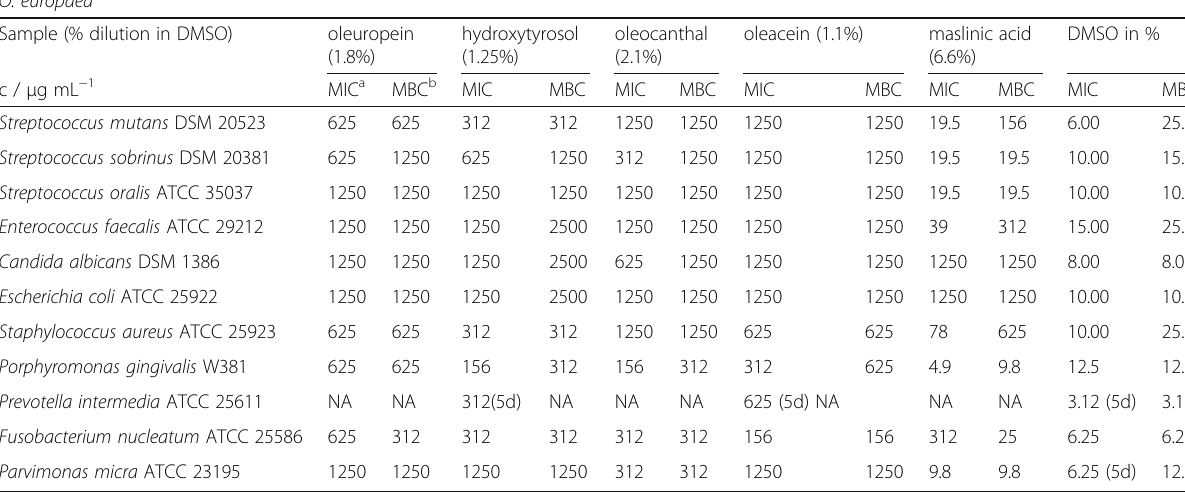
Table 1 Antimicrobial activity in μ g mL -1 of compounds from O. europaea O. europaea Sample (% dilution in DMSO) oleuropein